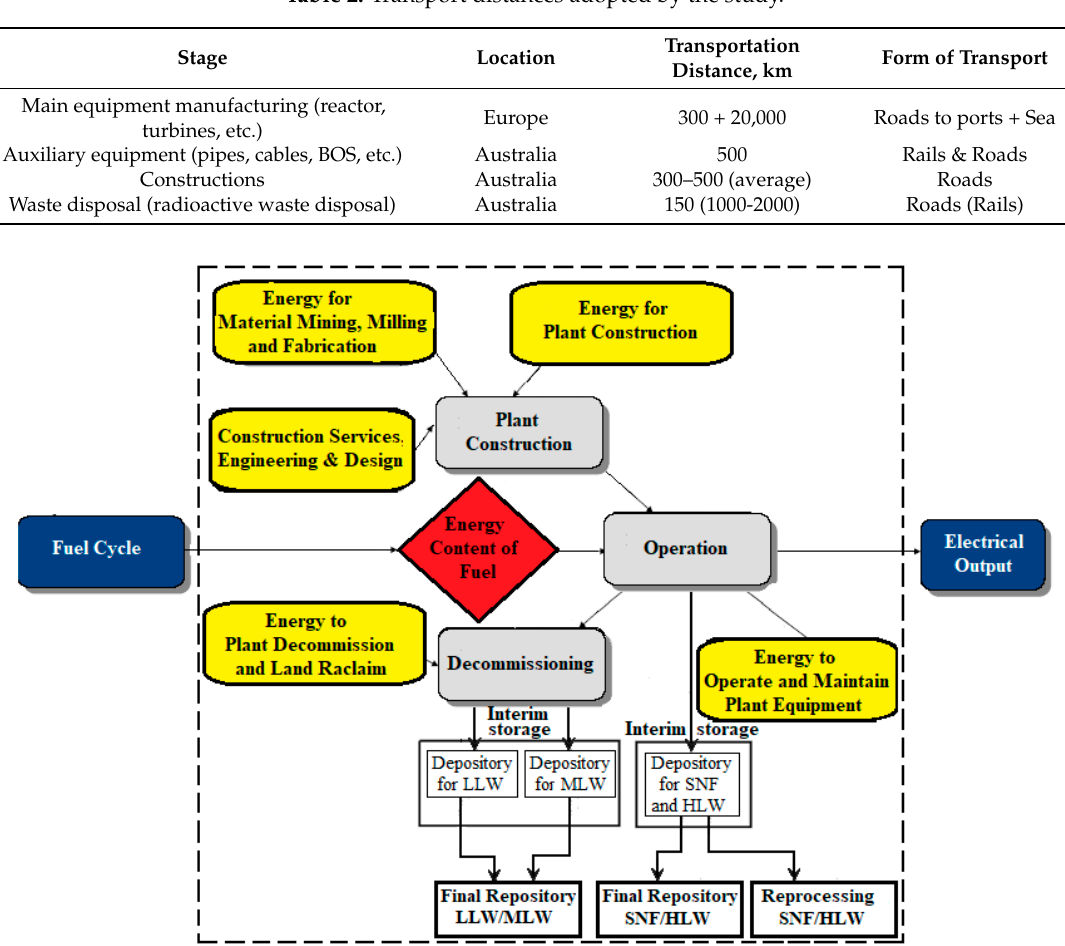
Table 2. Transport distances adopted by the study.